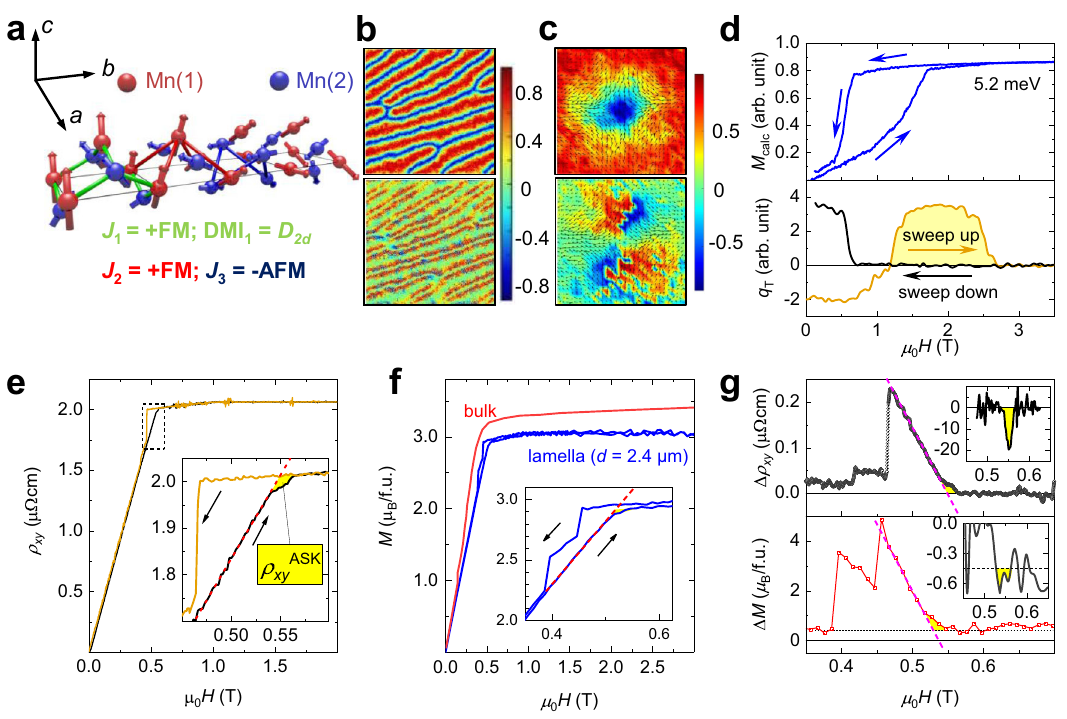
Fig. 2 Magnetic structure of Mn 1.4 PtSn. a Sketch of the relevant interaction and coupling constants linking the two Mn sublattices (red and blue). b , c Atomistic spin-dynamic simulations for H ∥ c : Color maps for an array of (372 × 372) unit cells showing the perpendicular z component in the spin-spiral phase (left) and ASK phase (right), respectively. Black arrows represent the in-plane component. The color scale is given in radiant, where 1/ − 1 corresponds to a spin alignment parallel/antiparallel to the normal. Lower panels show the in-plane spin-winding component. d Upper panel: Calculated magnetization loop for fi xed temperature given in meV; Lower panel: Calculated topological charge for opposite fi eld-sweep directions (orange and black line). e Full up and down Hall-resistivity traces for device C ( d = 2.4 μ m) recorded at 300 K. Inset: Reduced-area plot. Arrows indicate the fi eld-sweep direction. Red dashed line is a linear fi t. f Magnetization for a bulk sample and device C, recorded before it was structured into a Hall bar by FIB. Inset: Reduced-area plot. g Differences between up and down sweeps for the Hall and magnetization data shown in e and f , respectively. Insets: Background- subtracted component related to the fi eld region where ASKs are